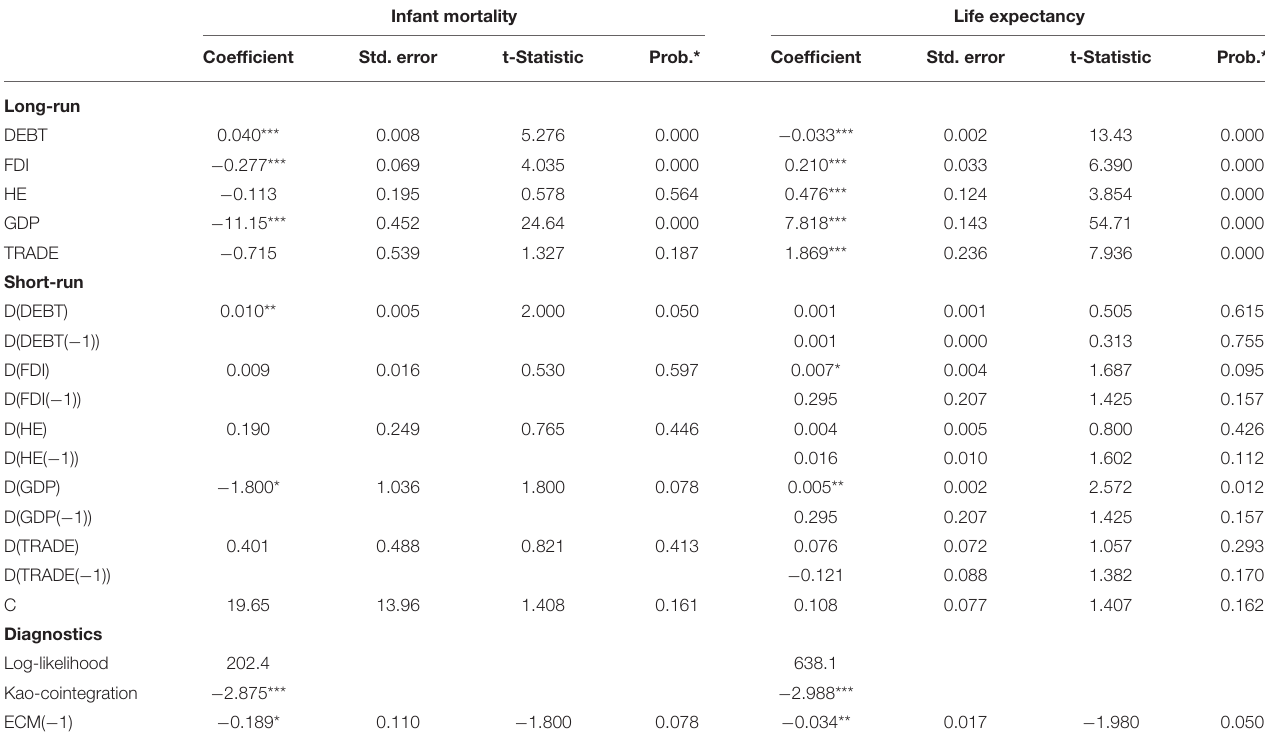
TABLE 3 | Long and short-run estimates of